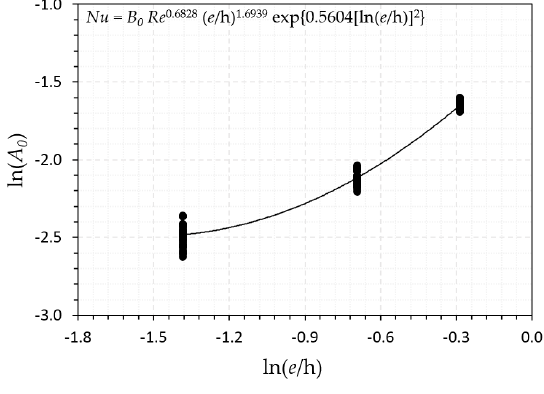
Figure 16. Plot of ln ( A o ) as function of ln ( e / h).